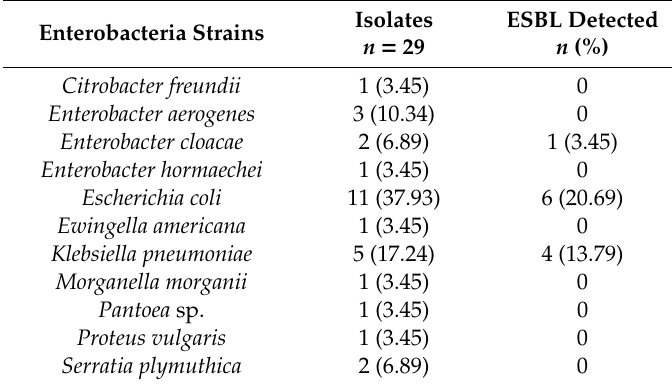
Table 2. Bacterial strains isolated from fruit